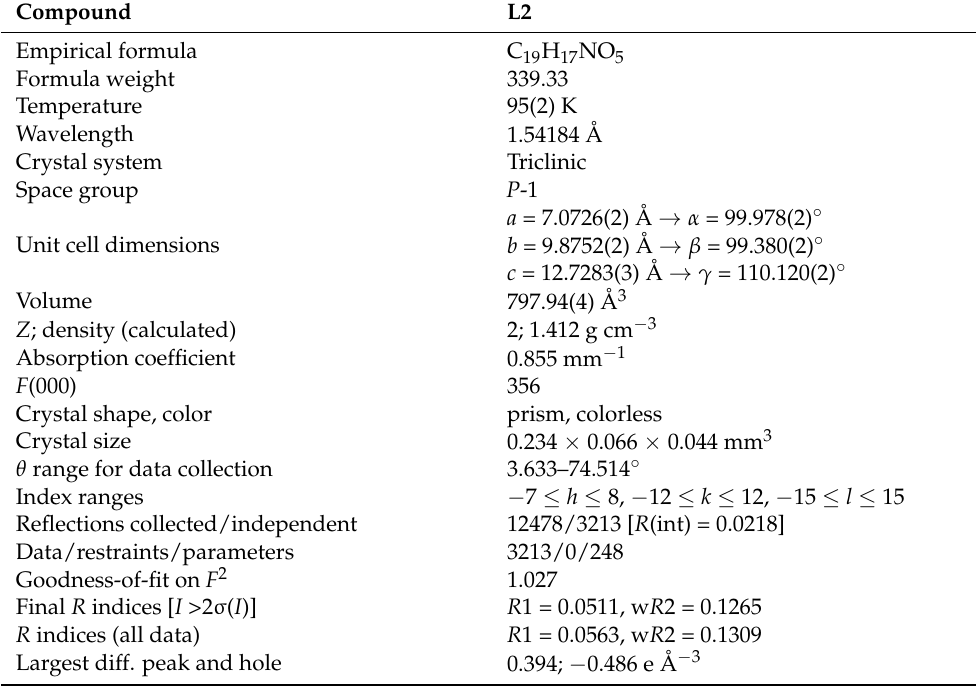
Table 1. Crystal data and structure refinement of L2